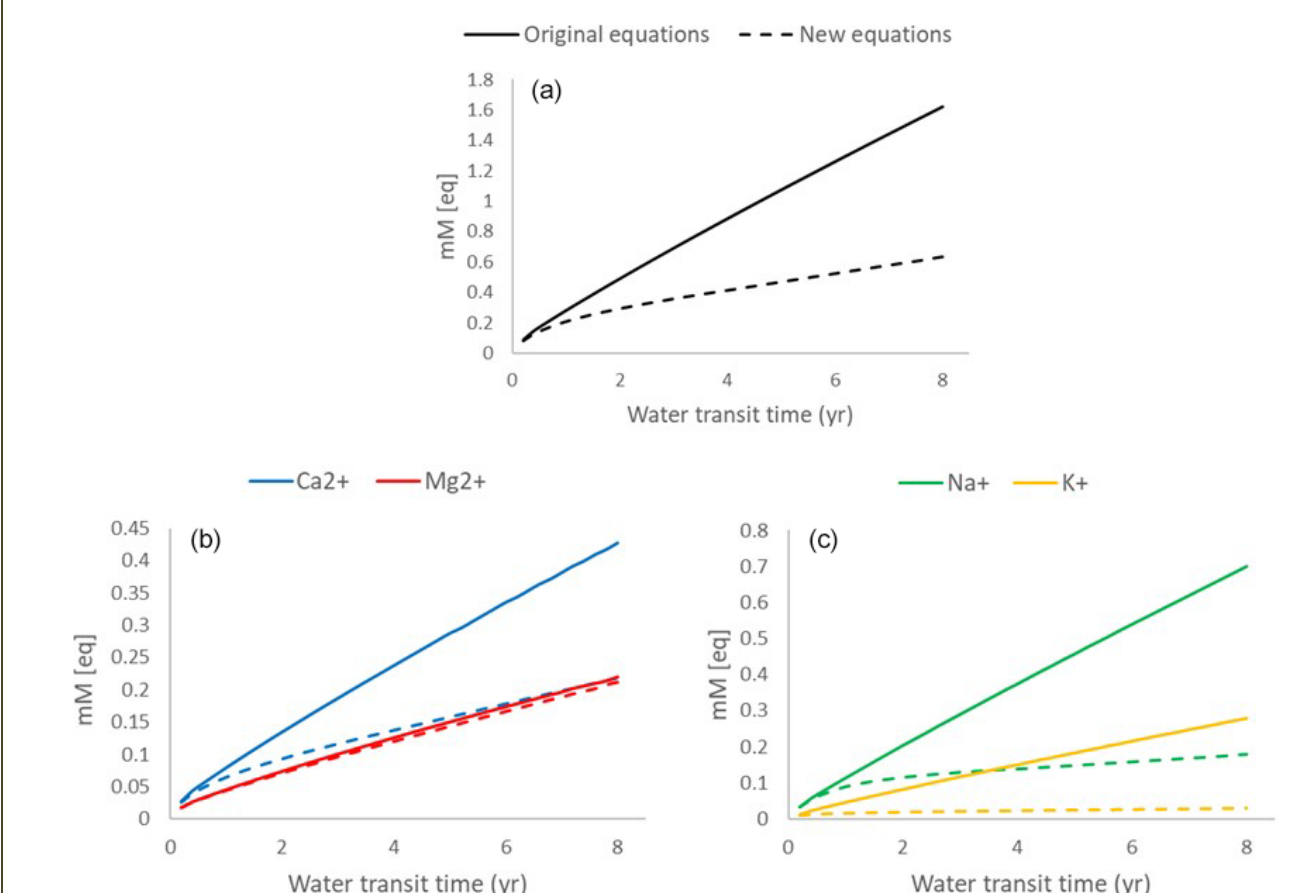
Figure 5. Calculated WTT–concentration relationships for the original (solid line) and new (dashed line) PROFILE equations. (a) Total BC concentrations (black); (b) Na + (green) and K + (yellow) concentrations; and (c) Ca 2 + (blue) and Mg 2 + (red)